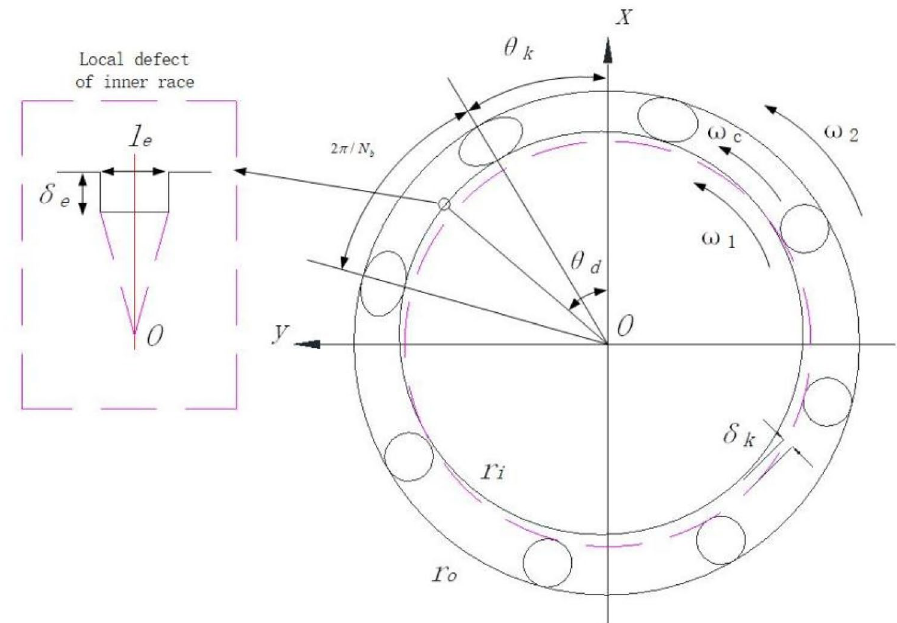
Figure 2. Schematic diagram of the inter-shaft bearing.